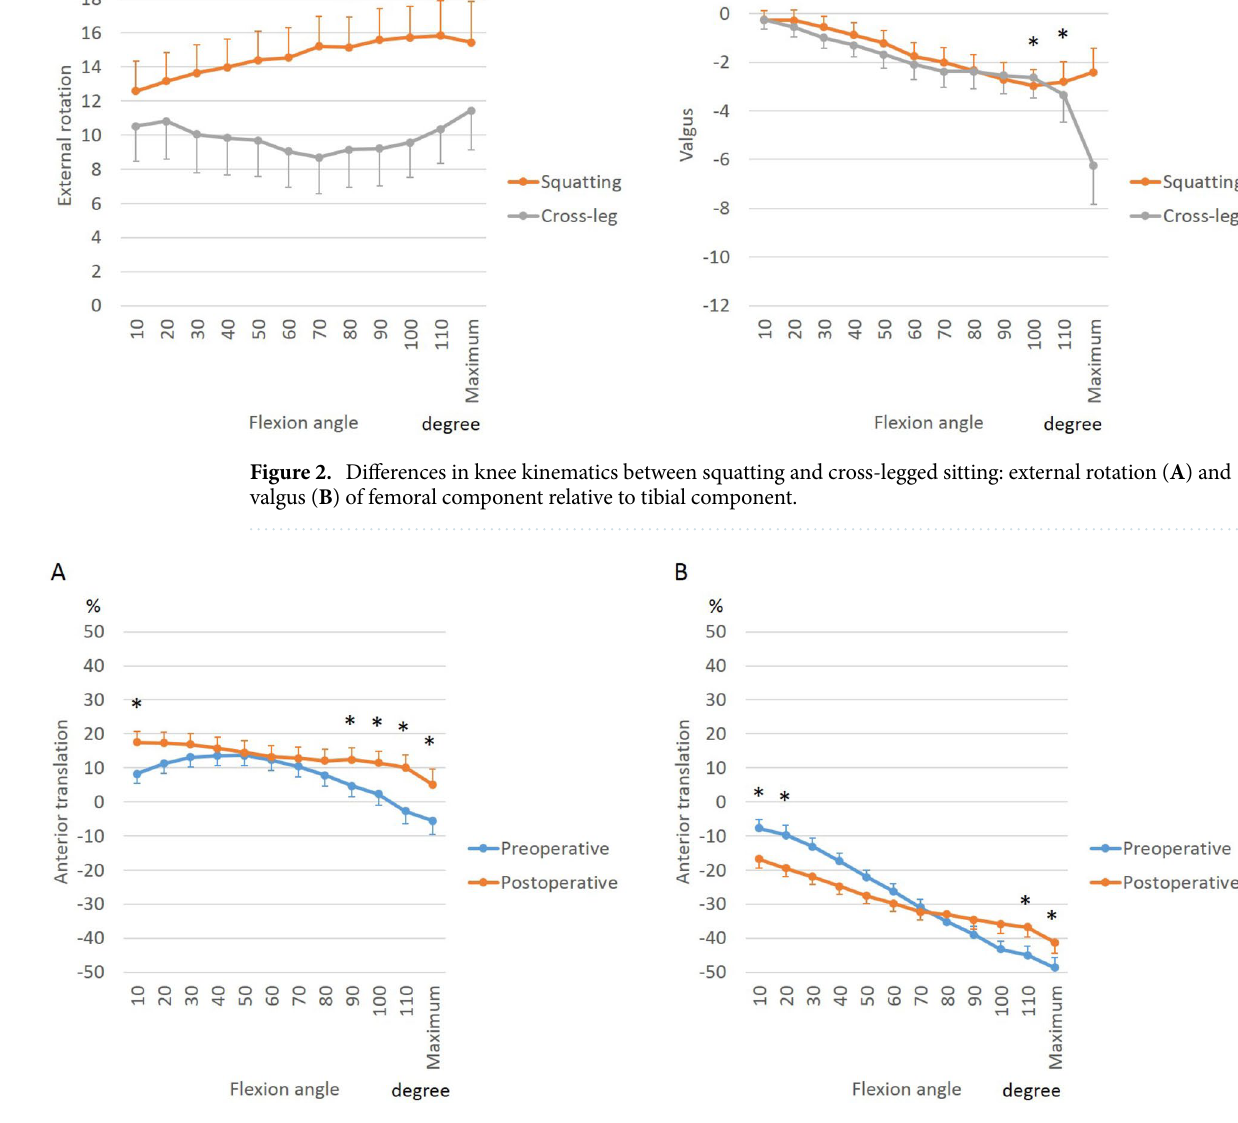
Figure 3. Effect of BCR-TKA on femoral AP translation of medial ( A ) and lateral ( B ) femoral condyle during